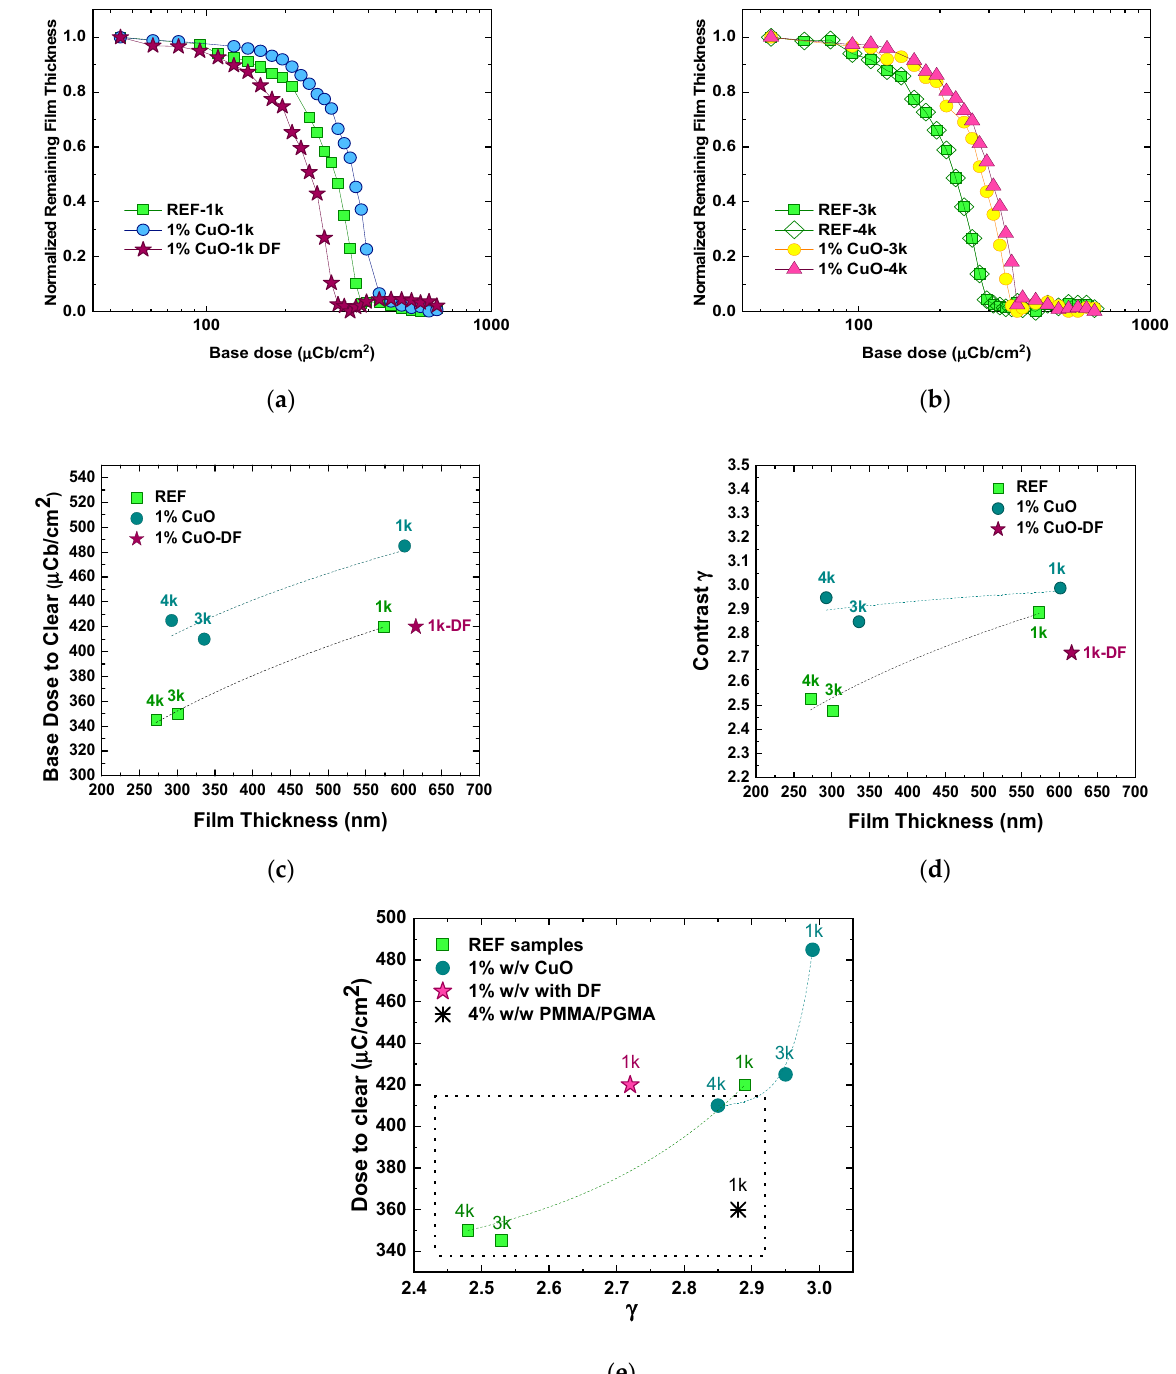
Figure 6. Contrast curves (Normalized Remaining Thickness as a function of the base dose) for patterned samples with films spin-coated at ( a ) 1000 rpm, ( b ) 3000 and 4000 rpm; ( c ) sensitivity (expressed as the minimum DTC) versus film thickness, ( d ) contrast γ versus film thickness, and ( e ) dose-to-clear versus contrast γ for all nanocomposite films of Phase 1 that were evaluated as EBL resists. The dotted rectangle includes resist films of similar thicknesses of ~260–300 nm. Dashed lines in graphs of ( c – e ) serve only as a guide to the eye, while labels indicate the spin-coating rotation speed in rpm.